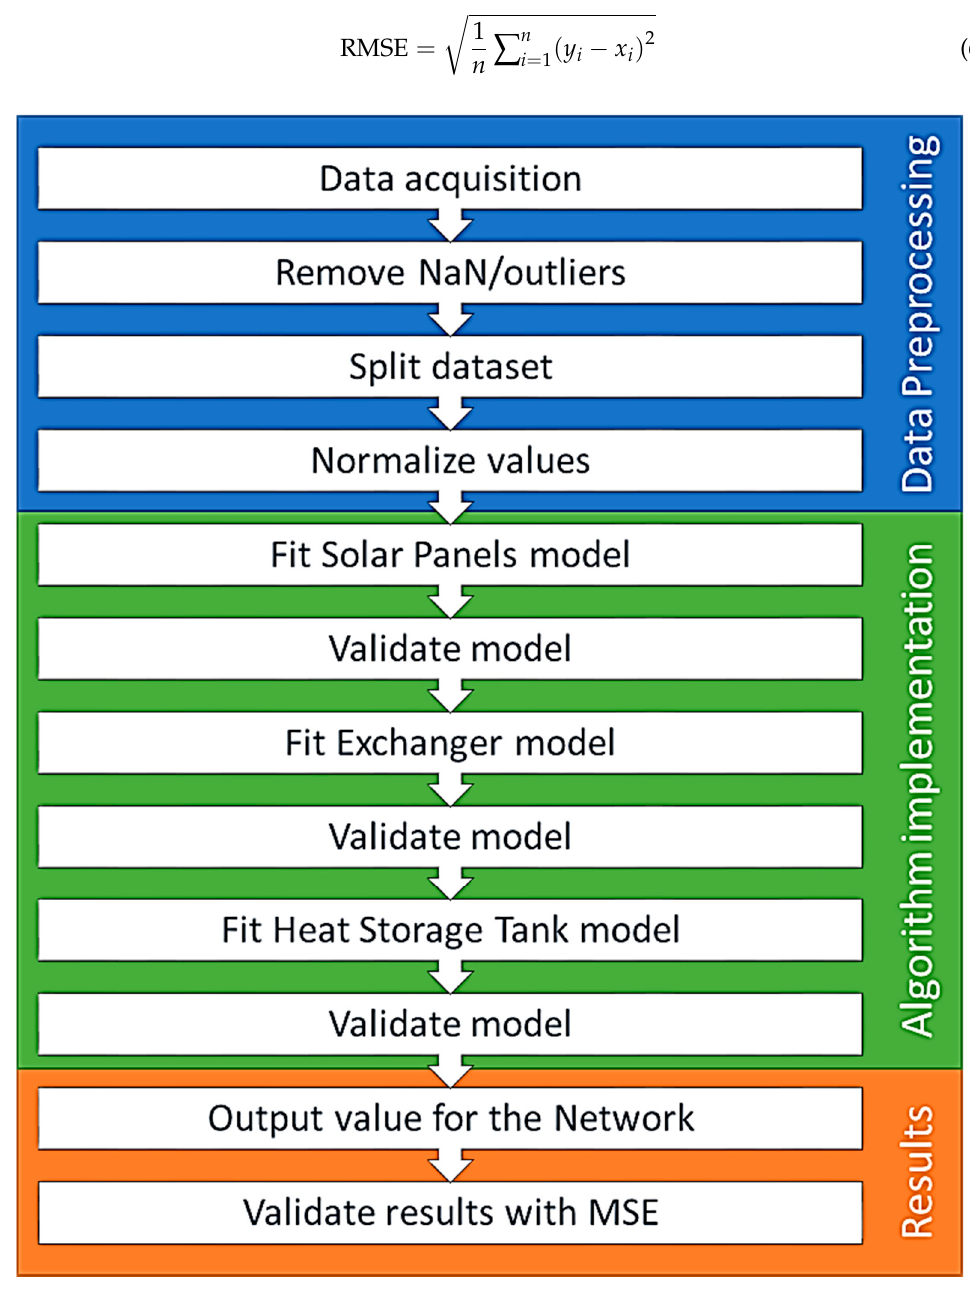
Figure 6. Flowchart of the methodology followed in this study.